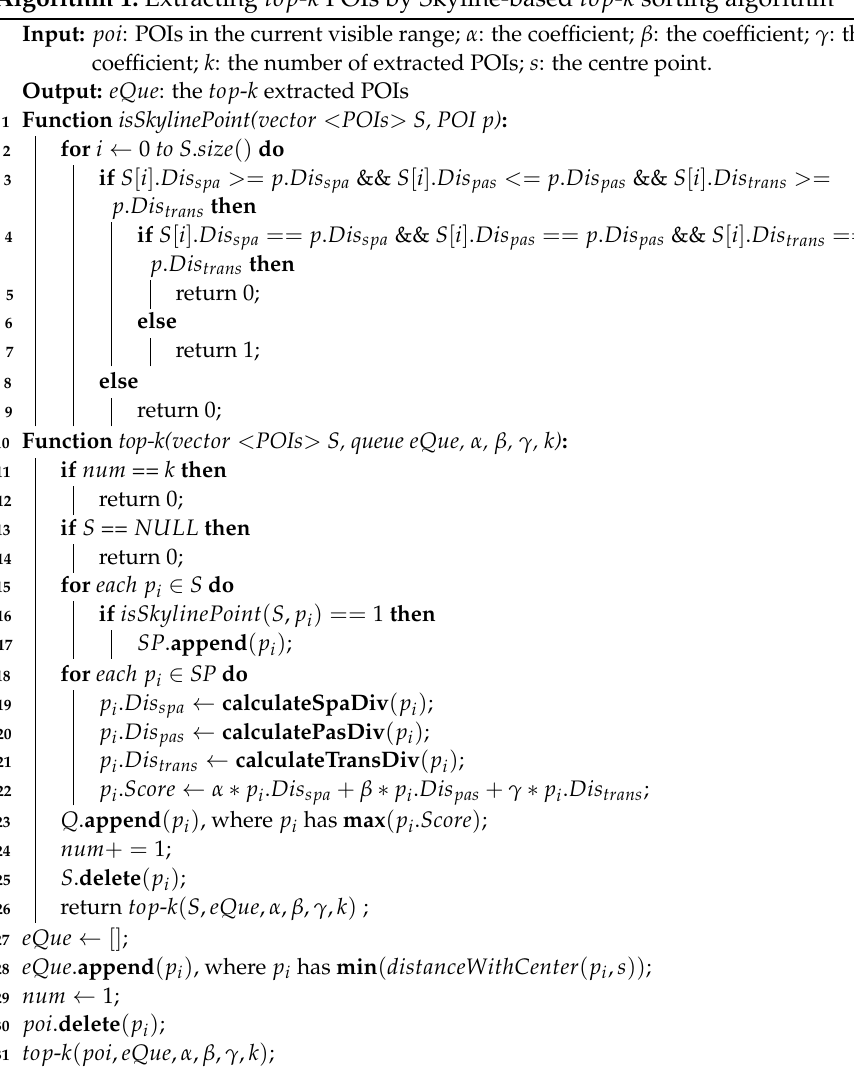
Algorithm 1: Extracting top - k POIs by Skyline-based top - k sorting